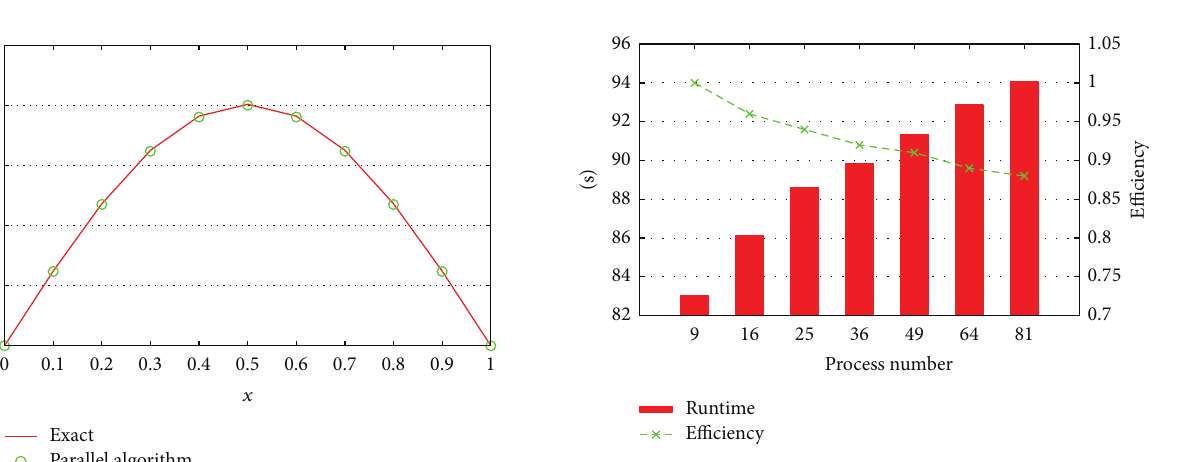
Figure 9: Scalability of the parallel algorithm on the cluster